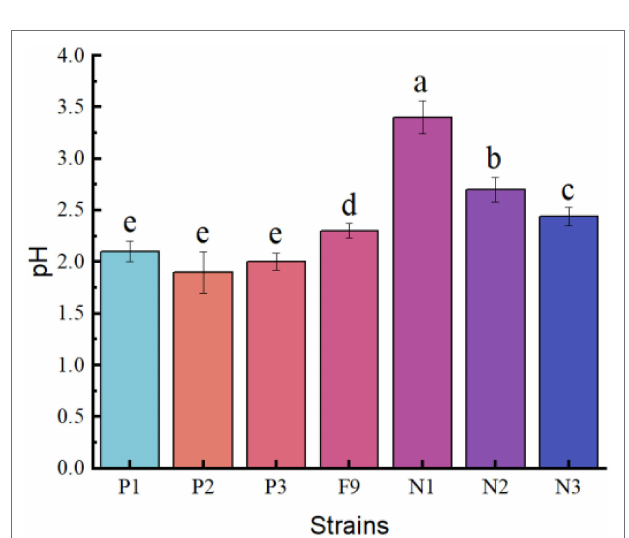
FIGURE 6 | The pH of the PSFM culture medium of Penicillium oxalicum F9 and mutants. a, b, c, d, and e indicate significant differences in various